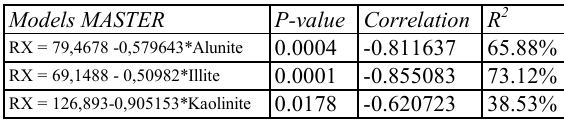
Table 2. Comparison of relationships between spectral anomalies and hydrothermal alteration, from MASTER images.